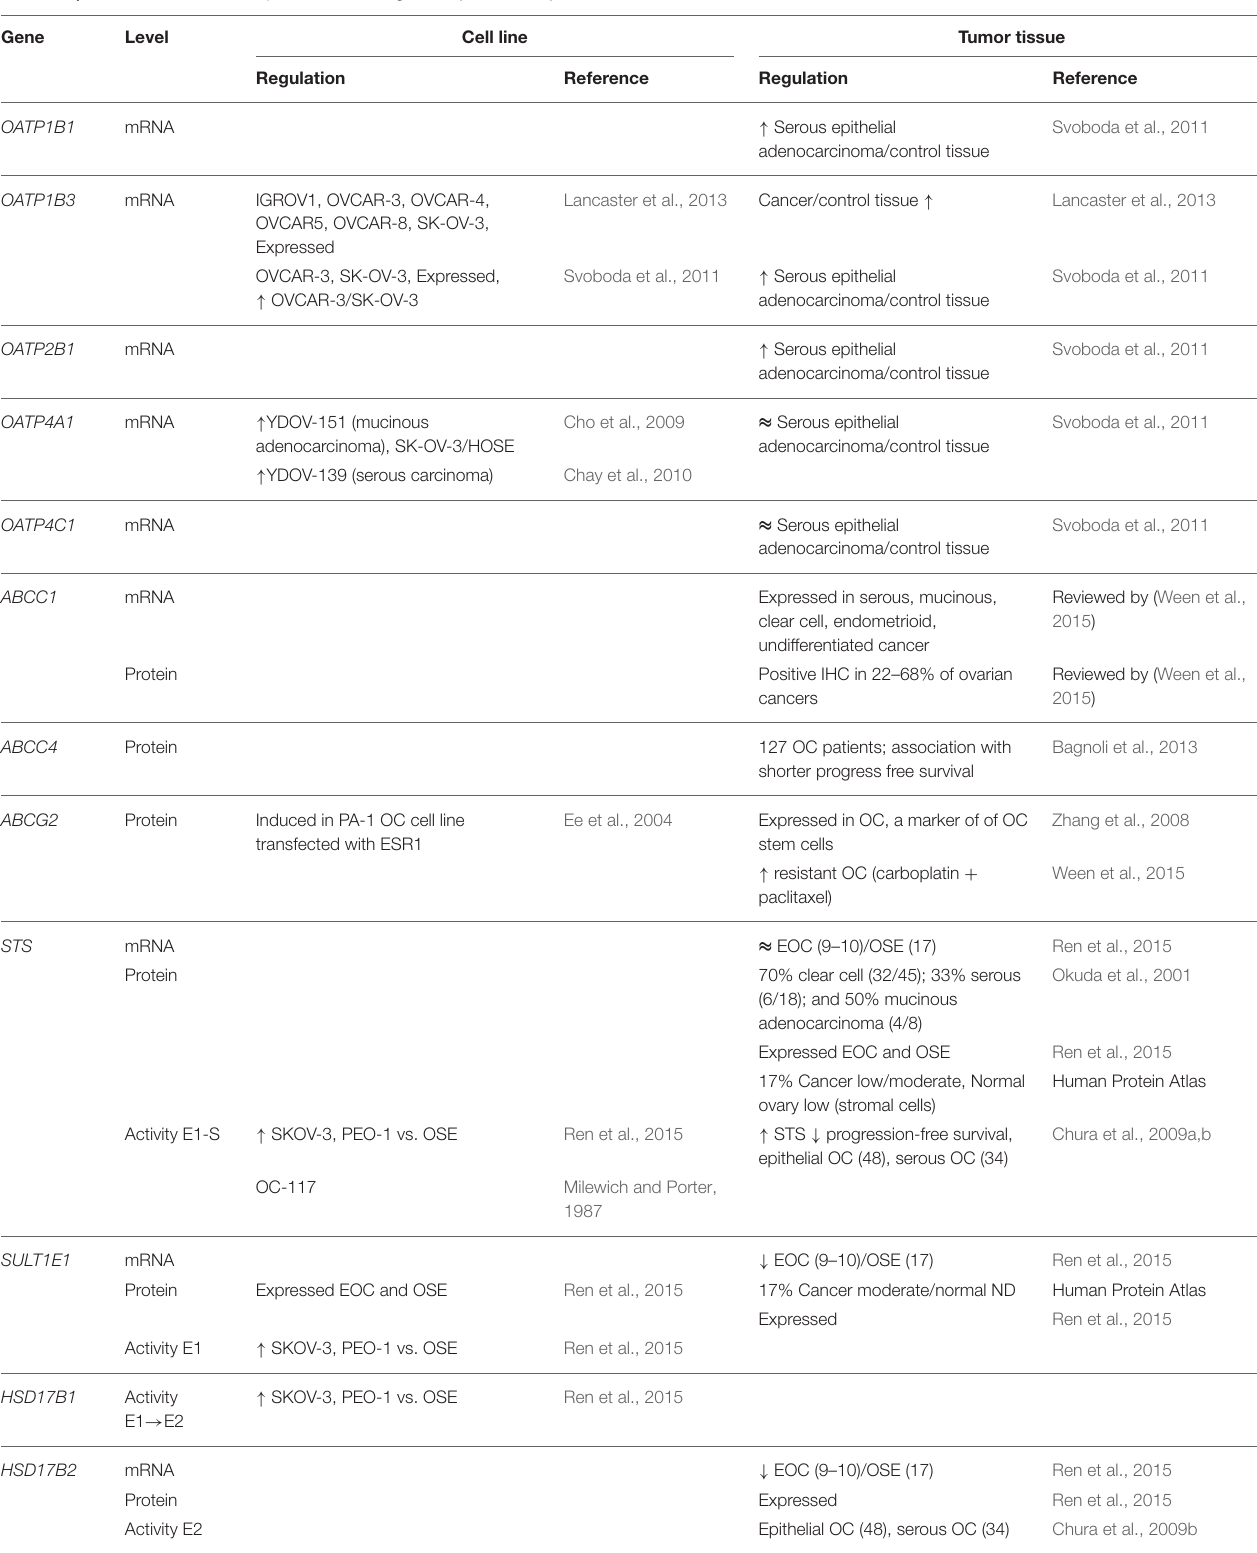
TABLE 4 | DHEA-S and E1-S transporters and estrogen biosynthetic enzymes in ovarian cancer.